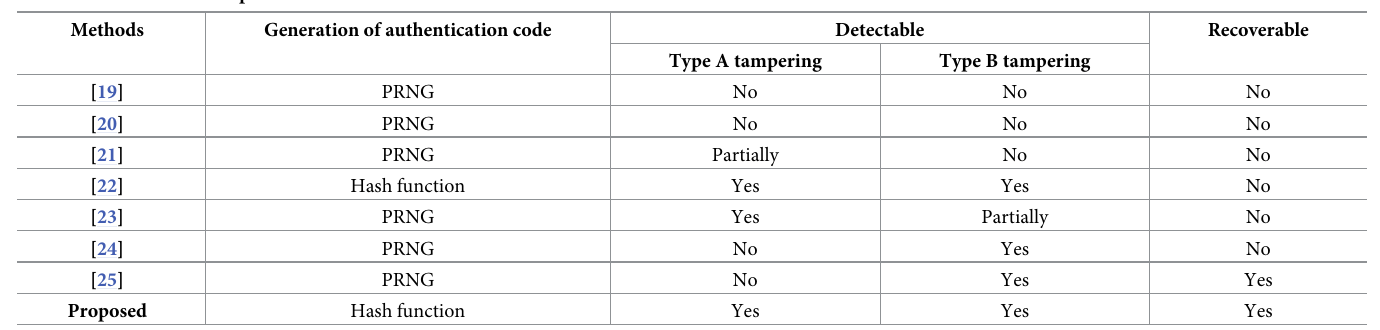
Table 6. Performance comparisons of related methods.